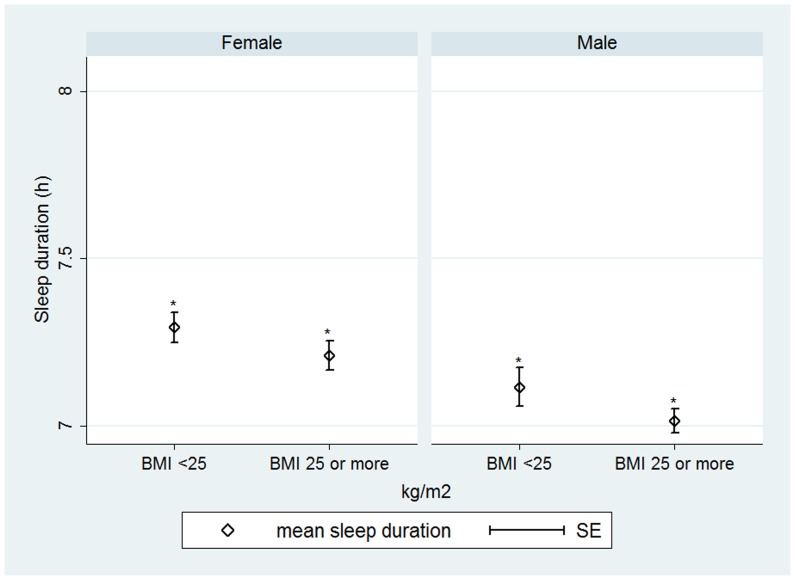
Sleep duration and overweight risk.The figure shows mean sleep duration between persons with normal weight (BMI<25 kg/m2) and overweight (BMI≥25 kg/m2). Statistically significant differences are marked with * (p<0.05).